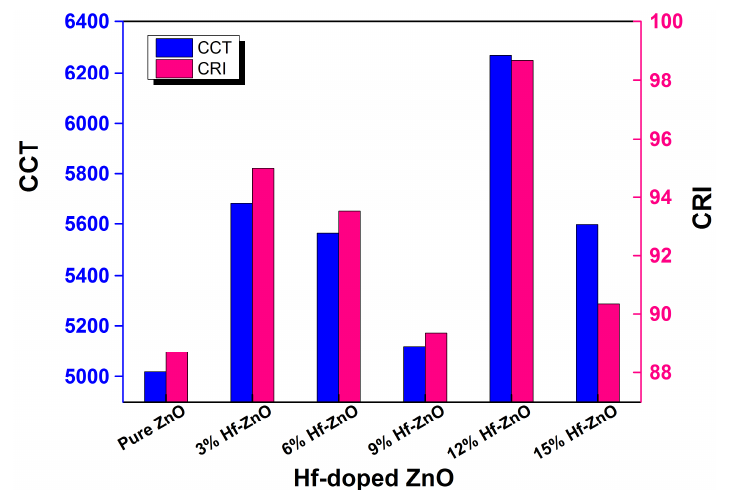
Figure 6. Color rendering index ( CRI ) and correlated color temperature ( CCT ) of pure and Hf-doped ZnO thin films.